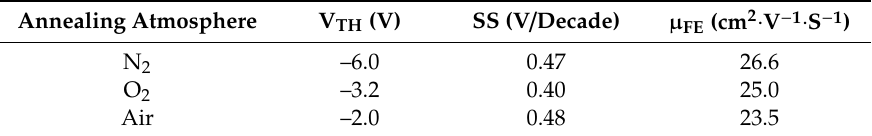
Table 1. Electrical parameters of N 2 -, O 2 -, and air-annealed IGTO TFTs.